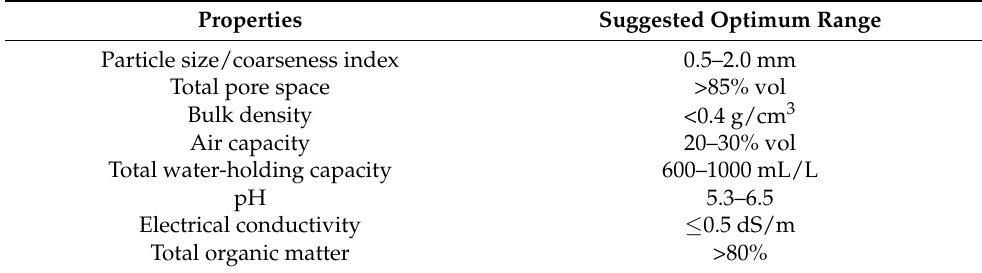
Table 3. Optimum range conditions of the substrate